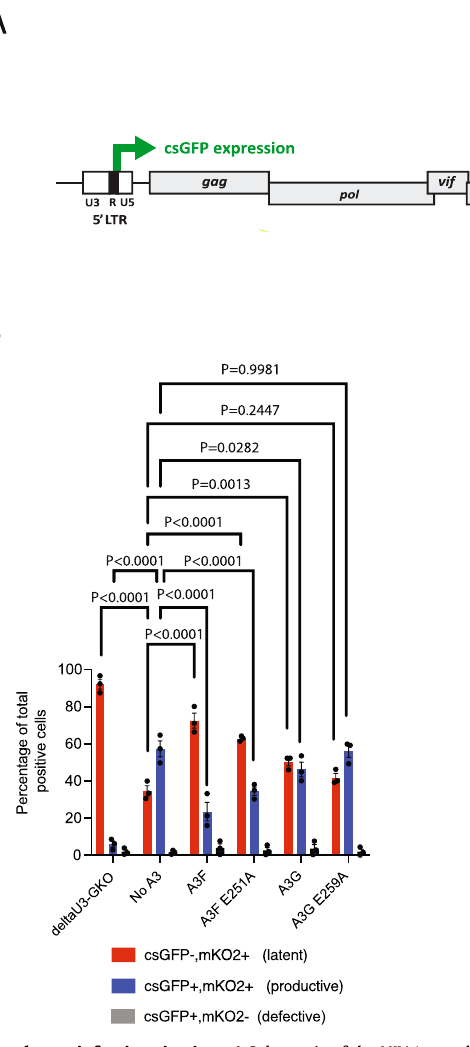
cells ((csGFP − , mKO2+) (red bars) or (csGFP+, mKO2 − ) (gray bars)) is shown. Sta- tistical analysis was performed using two-way ANOVA with Dunnett ’ s multiple comparisons test (degrees of freedom=36). C The average proportion of latently infected cells (csGFP − , mKO2+) from panel B is shown. Statistical analysis was per- formed using one-way ANOVA with Tukey ’ s multiple comparisons test (degrees of freedom=12). Data shown represents the mean values (±S.E.M.) from three inde- pendent experiments. Source data are provided as a Source Data fi